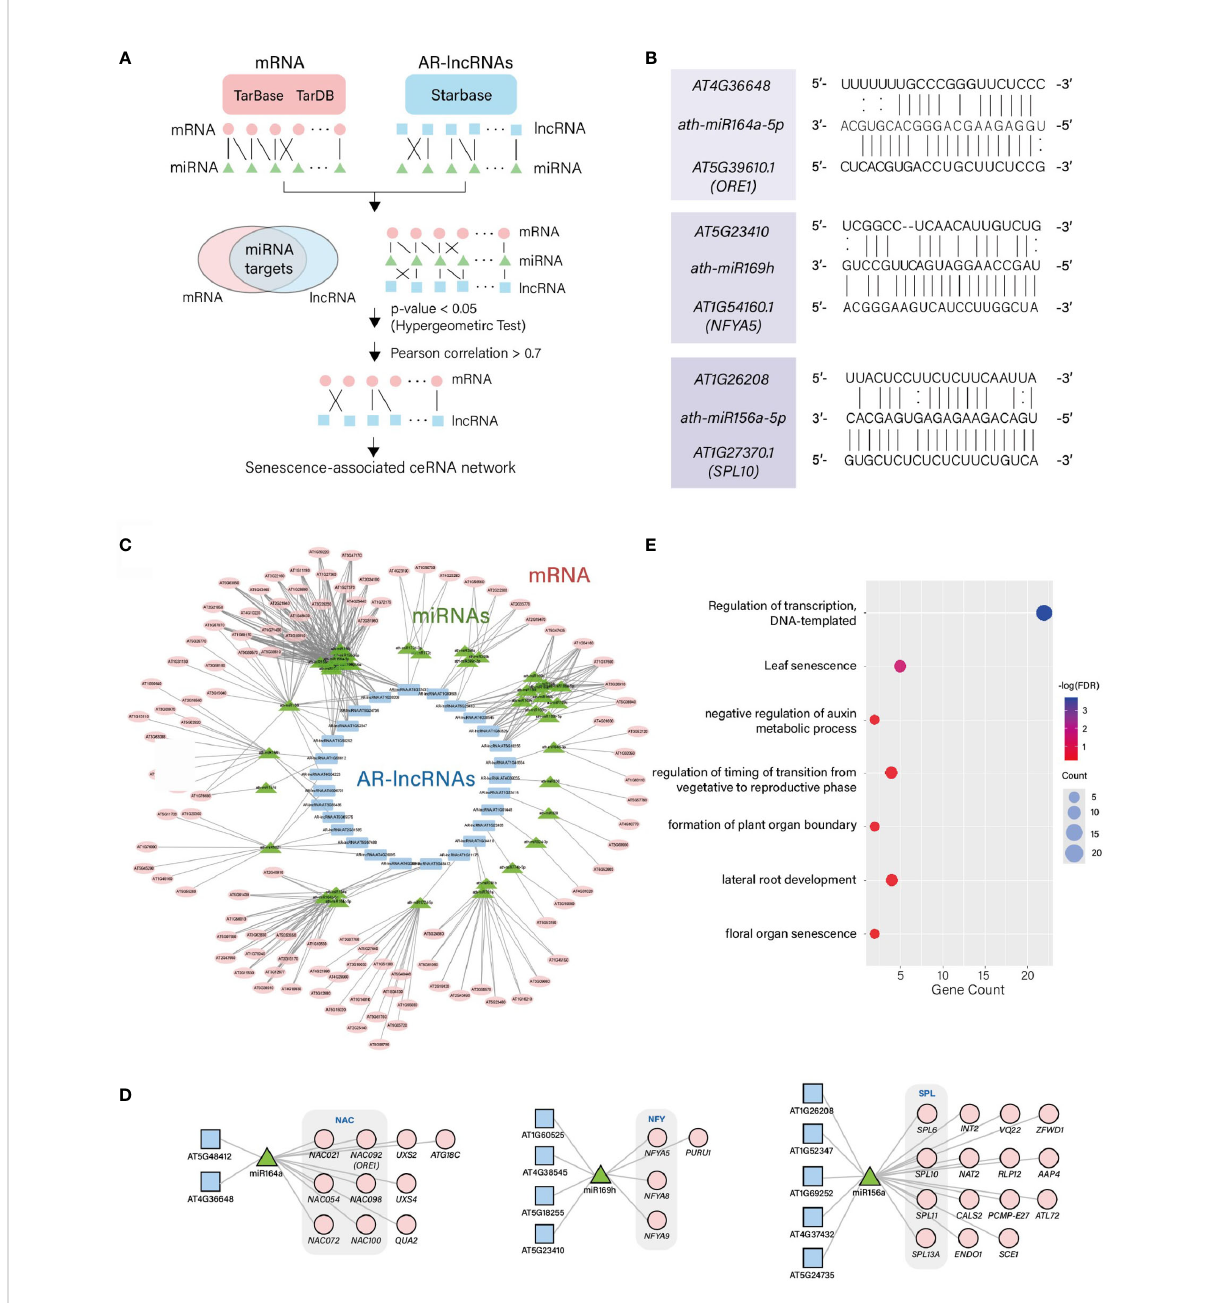
FIGURE 4 Identi fi cation of ceRNA sets containing AR-lncRNAs involved in leaf senescence. (A) Framework used to predict the ceRNA sets containing AR- lncRNAs. (B) Alignment of representative miRNAs and AR-lncRNAs. (C) ceRNA regulatory networks. (D) Three representative network modules showing the identi fi ed leaf senescence-related ceRNA sets. (E) Enriched GOBPs of mRNAs involved in ceRNA